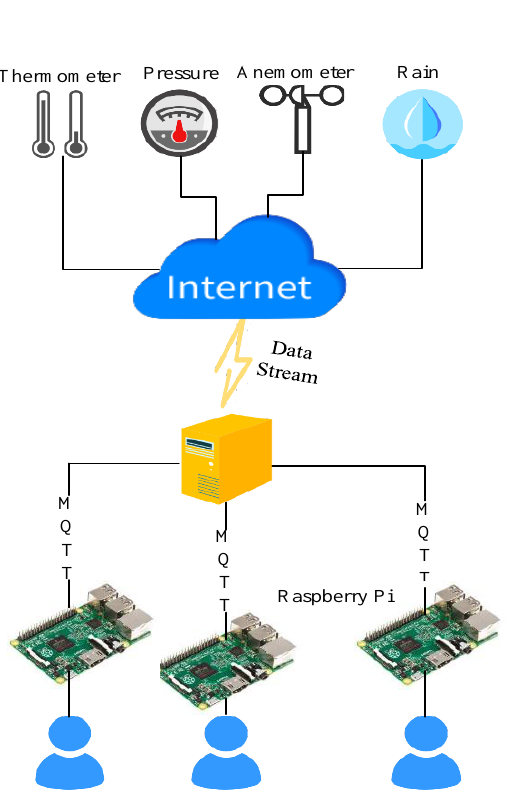
Figure 2. The design of the architecture based IoT and semantic web